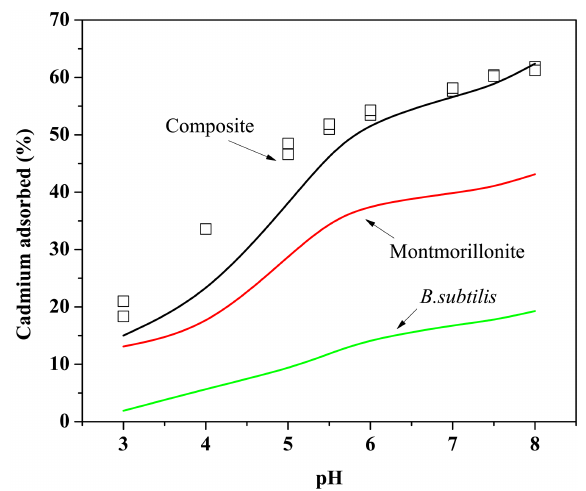
Figure 4. Distribution of the total adsorbed Cd between mont- morillonite and B. subtilis fractions in the composite predicted by CA-SCM (symbols are data points, lines are model fits) at 28 ◦ C in the presence of 0.01MNaNO 3 . Cd(II):10ppm, compos- ite: 0.875gL − 1 Mont + 0.125gL − 1 B. subtilis .